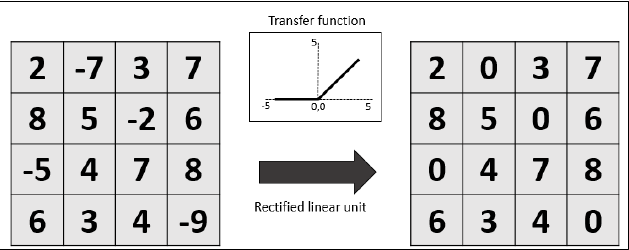
Figure 8. ReLU Figure 8. ReLU operation.